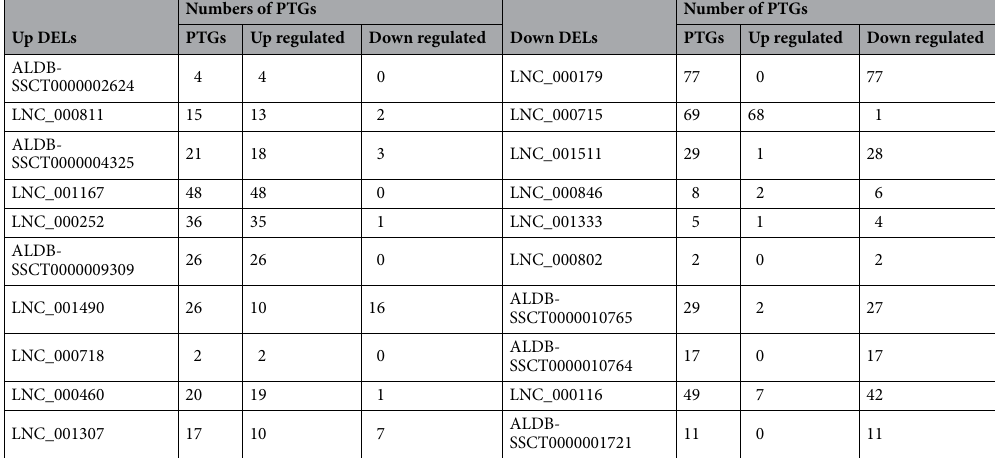
Table 2. Differentially expressed lncRNAs (DELs) and their target genes (PTGs).